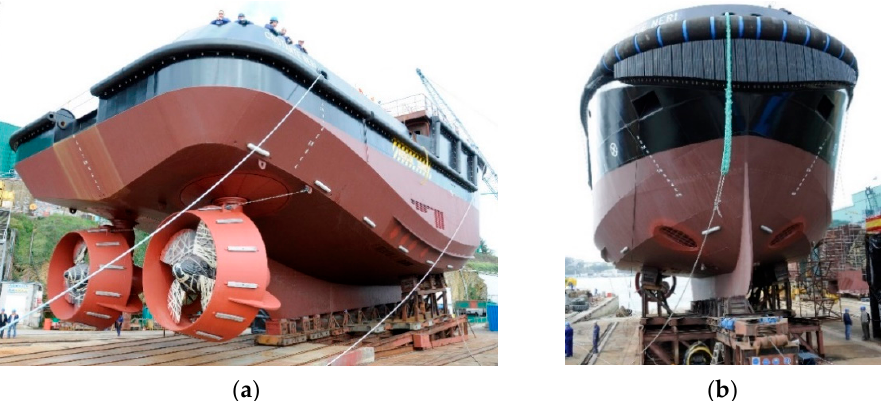
Figure 3. ( a , b ) The ASD escort tug “Costante Neri” delivered in September 2009 by Gondán Ship- yard, S.A. (Spain), to the owner Fratelli Neri S.p.A. (Italy). Photo: